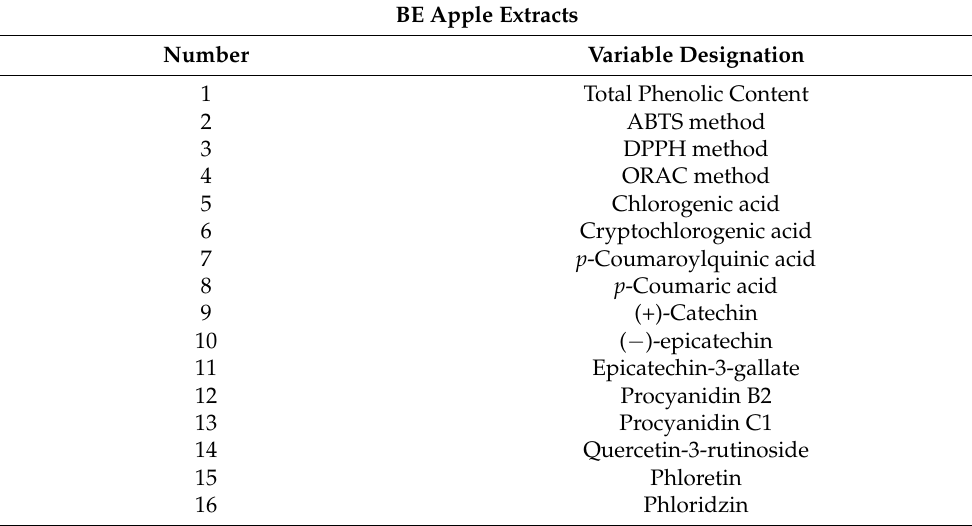
Table 4. Description of the 16 variables considered in PCA for BE apple